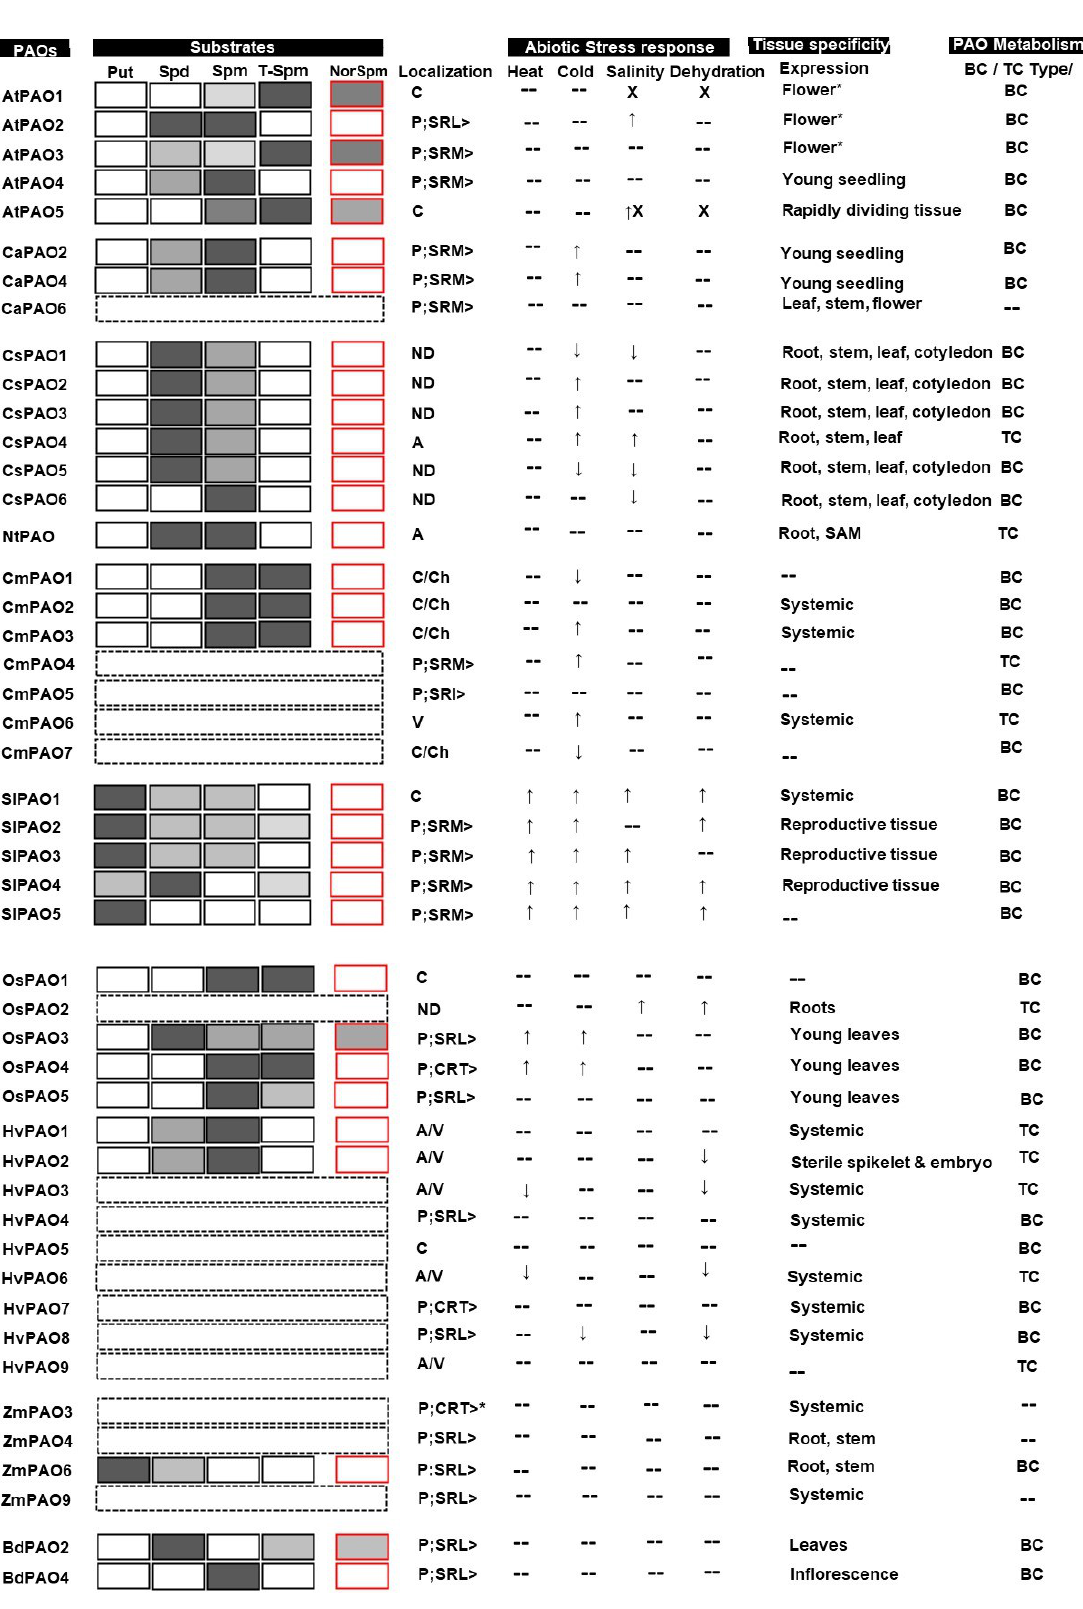
Figure 2. Diagrammatic representation of various properties of PAO enzymes. The left column shows the PAO enzymes from various plant species. The substrates of PAO enzymes are shown with rectangular boxes. The preference of substrates by the respective PAO enzyme is shown with color gradation. The most preferred substrate has the densest color. The PA substrate that is not used by the respective PAO is left blank. The unusual PA (NorSpm) rectangles are bordered with